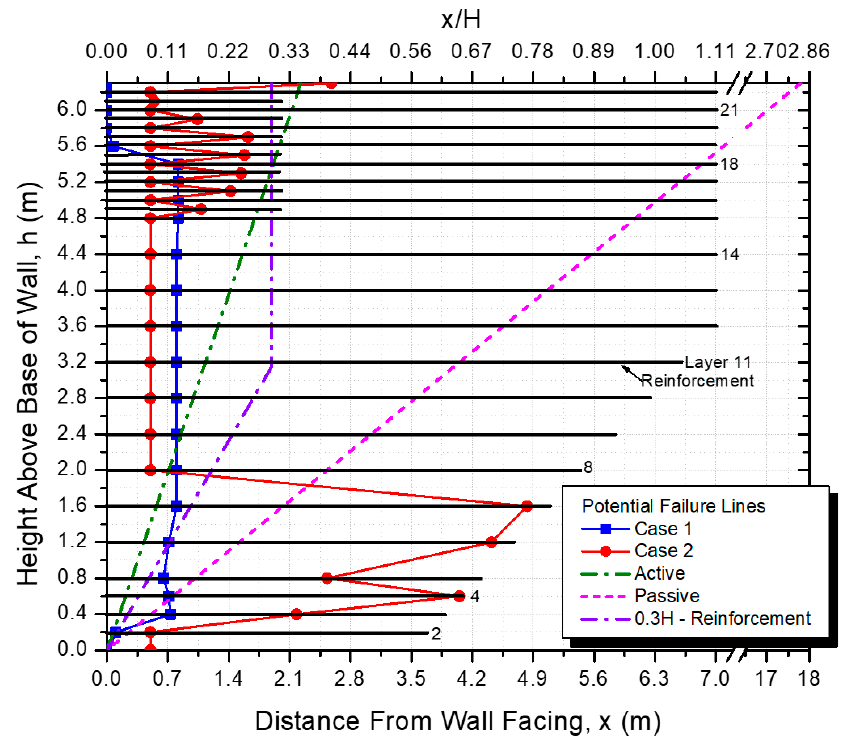
Figure 12. Locus of maximum reinforcement strain and potential failure surface.